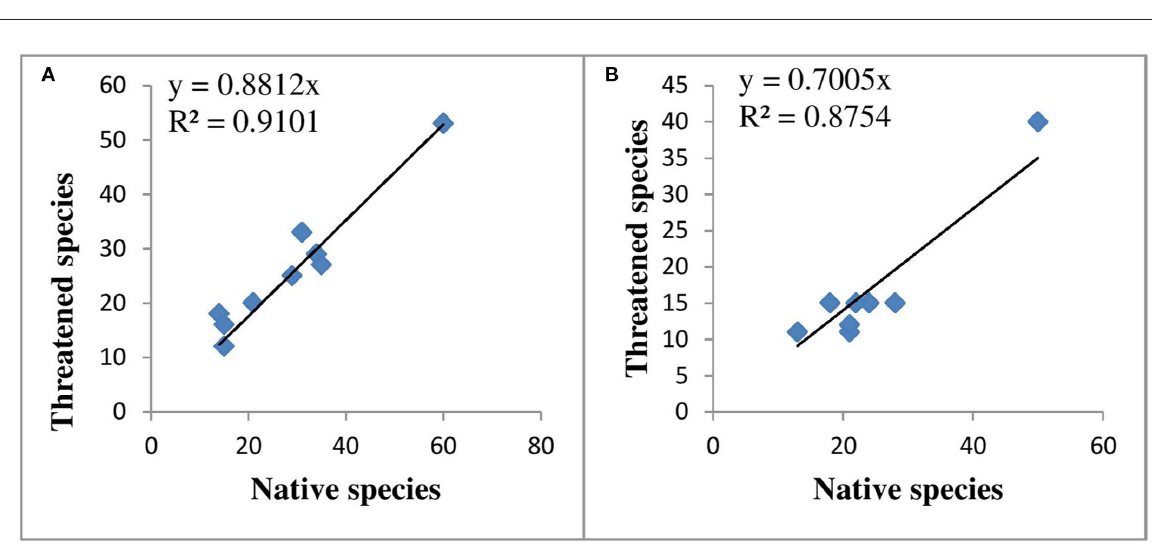
FIGURE7 Correlation of native species and threatened species (A) forest zone (B) alpine